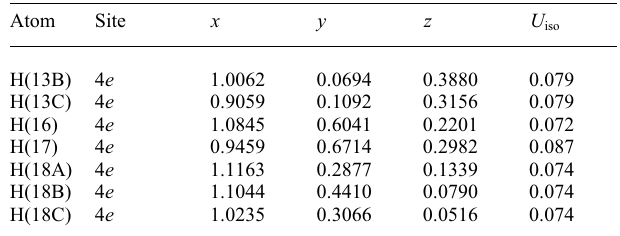
Table 2. Atomic coordinates and displacement parameters (in Å 2 )